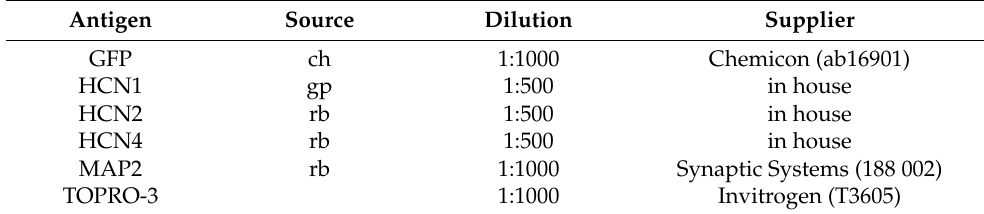
Table 1. Primary antibodies used for immunocytochemistry. List of primary antibodies applied for immunocytochemistry. Supplier: Chemicon, Merck/Sigma-Aldrich, Darmstadt, Germany; Synaptic Systems, Goettingen, Germany; Invitrogen/Thermo Fisher Scientific, Darmstadt, Germany. Abbrevi- ations: ch, chicken; gp, guinea pig; rb, rabbit.